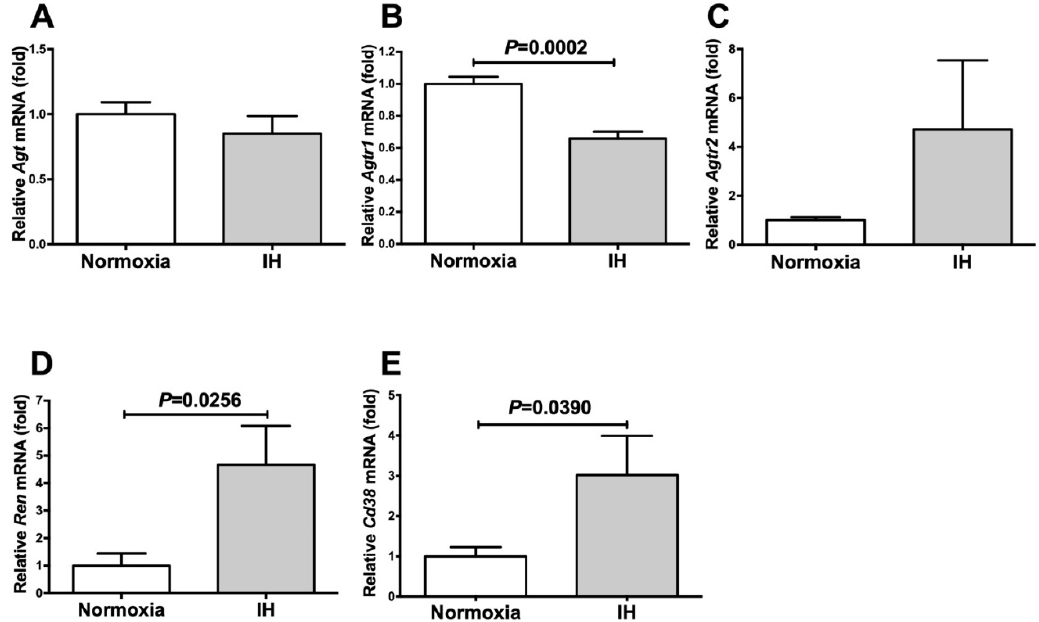
Figure 2. The mRNA levels of Agt ( A ), Agtr1 ( B ), Agtr2 ( C ), Ren ( D ), and Cd38 ( E ) in the As4.1 JG cells subjected to normoxia or IH for 24 h. The levels of the mRNAs were measured by means of a real-time RT-PCR using rat insulinoma gene ( Rig ) /ribosomal protein S15 ( Rps15 ) as an endogenous control. The data are expressed as the mean ± SE for each group of six independent experiments (n = 6). The statistical analyses were performed using a Student’s t -test.